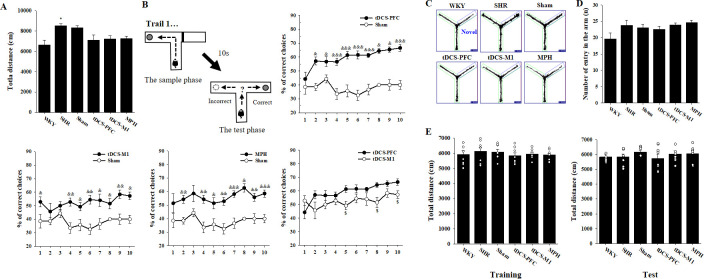
Additional data on cognitive behavior following HD-tDCS application in our rat model of ADHD.(A) Open-field test, total distance traveled (n = 8). (B) DNMTP T-maze, comparisons of total % correct choices (n = 7). (C) Modified Y-maze, example of performance image for a 10-min trial (n = 8). (D) Y-maze spontaneous alternation task, number of total arm entries during the 10 min trial (n = 7). (E) Object-place recognition test, mobility as measured by total distance traveled for 10 min during training and test trials (n = 8). Data are presented as mean ± SEM. *p<0.05 vs. WKY; &p<0.05, &&p<0.01 and &&&p<0.001 vs. sham; $p<0.05 vs. tDCS-PFC.